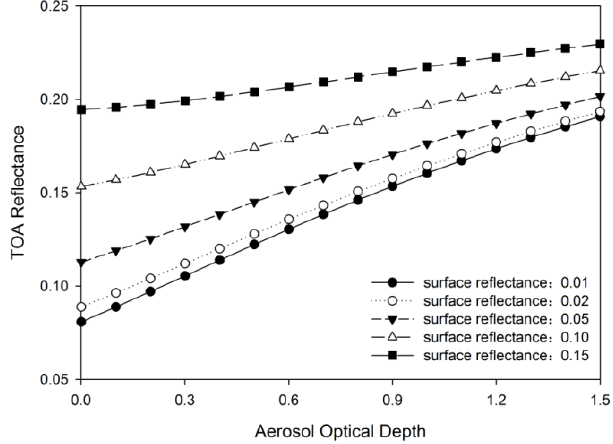
Figure 2. The relationship between AOD and TOA reflectance in the blue band (0.47 μ m) under different surface conditions.